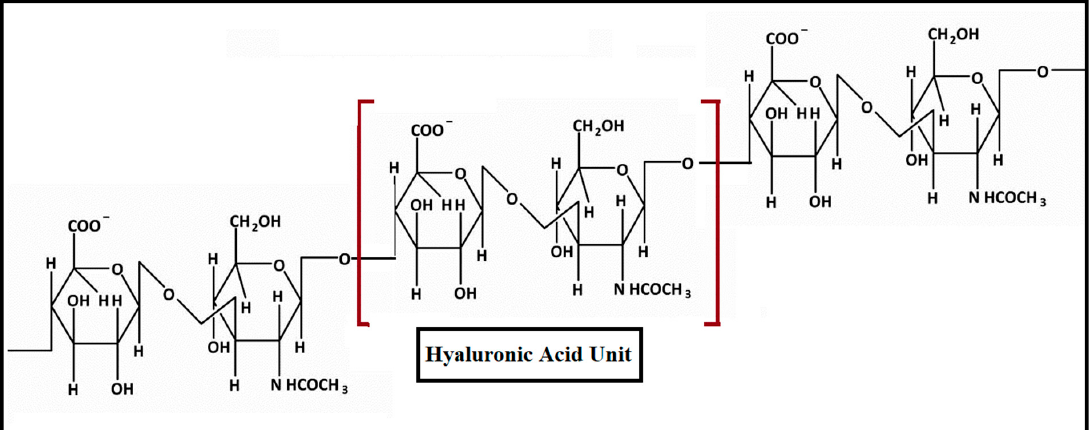
Figure 8. The structure of hyaluronic acid.